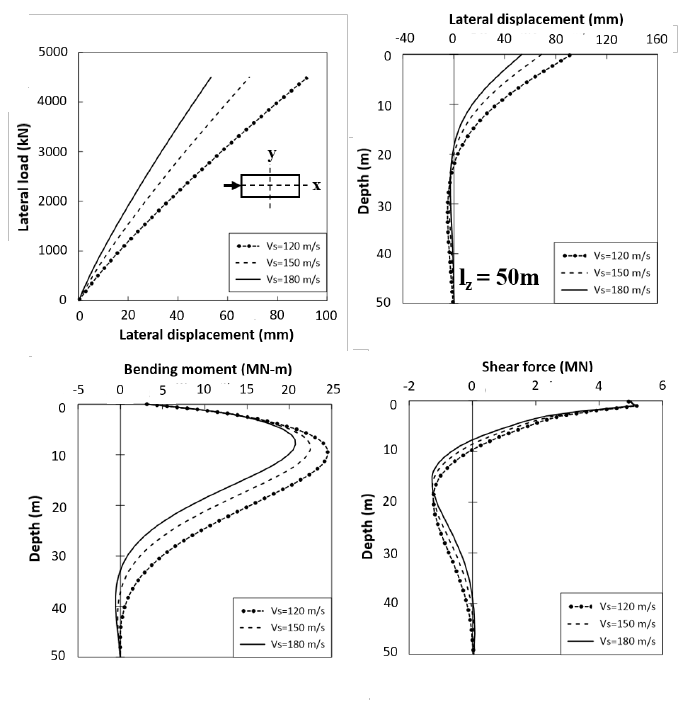
Fig. 11. Performance of 50m barrette in sands with load applied in longitudinal direction